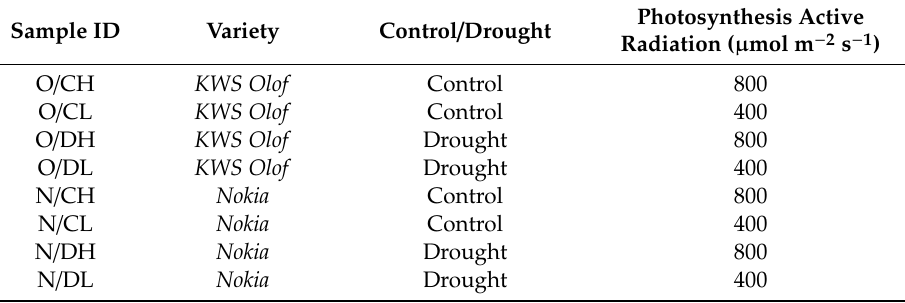
Table 8. Description of sample ID and cultivation